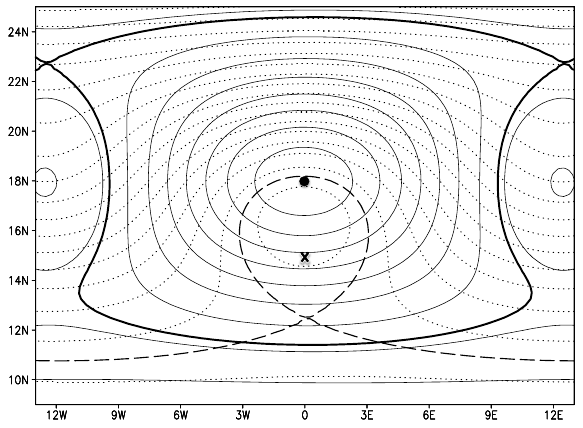
Fig. 5. Stream function in the resting frame of reference (dotted contours) and in the co-moving frame of reference (solid contours). The thick solid line is the bounding contour of the wave pouch in the co-moving frame of reference, and the thick dashed line delineates the closed circulation in the resting frame (stream function gyre). The circle and the cross indicate the pouch center and the mass centroid of resting stream function gyre, respectively.